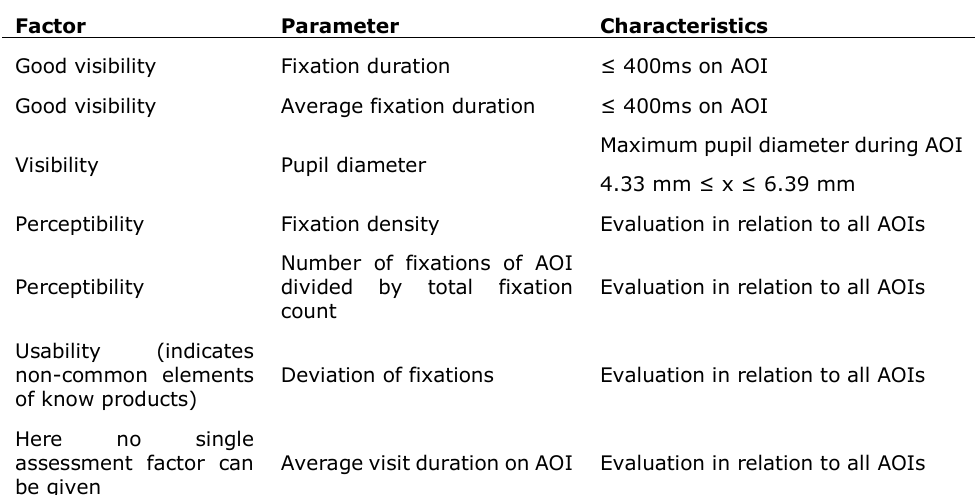
Table 1. Characteristics of the selected